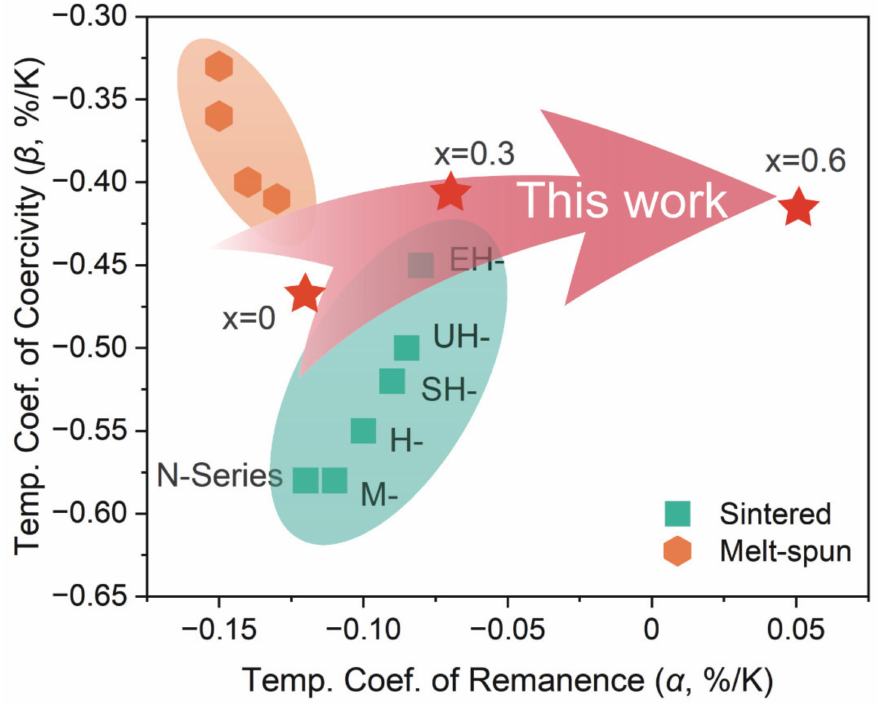
Figure 5. Microstructure characterization of NPHFBM alloys. Bright field TEM images and grain size distribution of the x = 0 ( a ), 0.3 ( b ) and 0.6 ( c ) alloys. The HRTEM image of the typical grain obtained from ( b ) for x = 0.3 alloy is shown in ( d ), and the corresponding FFT pattern is presented in the inset. The HAADF image obtained from ( b ) and corresponding EDS elemental mapping are shown in ( e ) and ( f ),